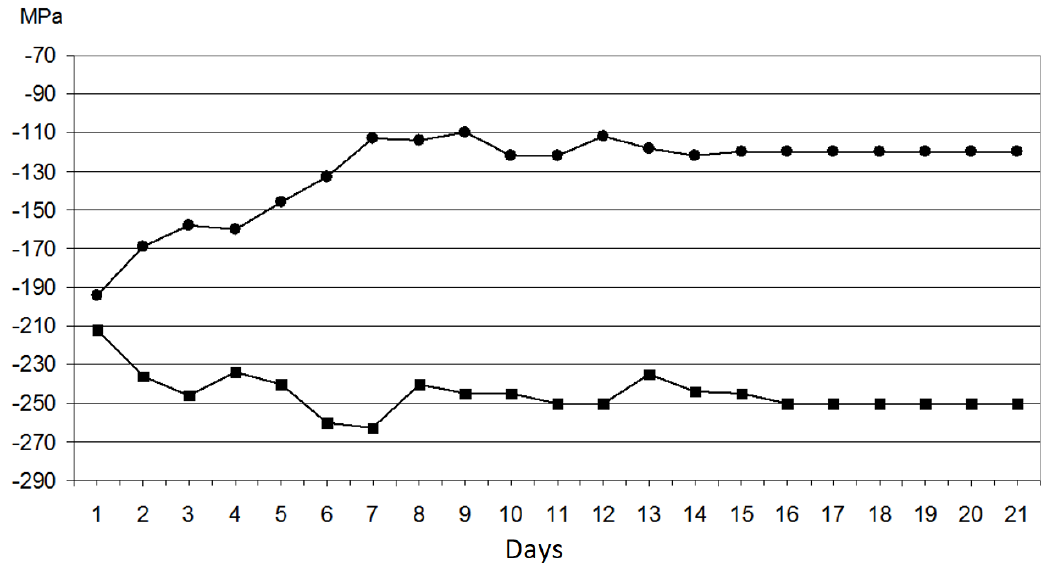
Figure 8. Change in residual stress over time. Plot with ● corresponds to the residual stresses measured on IC CGHAZ area; plot with ■ corresponds to the residual stresses measured on FGHAZ area. Table 2. Values of the change in residual stress over